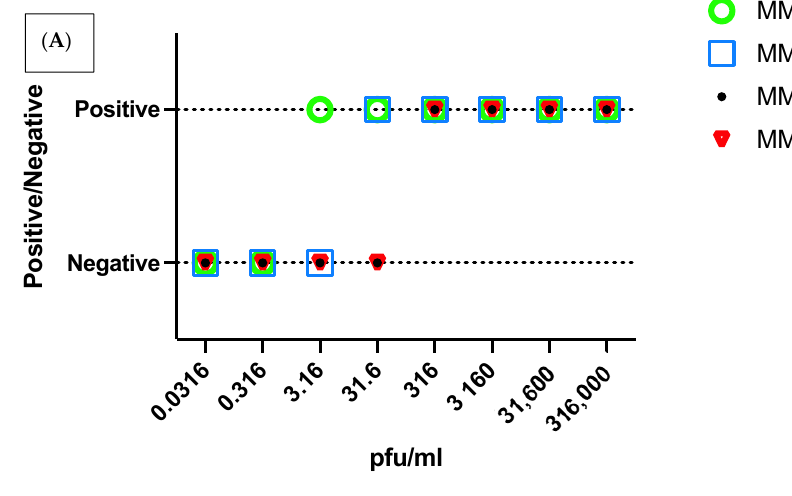
Figure 2. The LOD of MMix-A ( A ) and MMix-B ( B ) was evaluated at 60- 45- 40-, 35- and 30-min using cell culture isolates. The shortest time to give the highest level of detection (3.16 pfu/mL) for both assays was 45- and 30-min using MMix-A and MMix-B, respectively. 3.4. Evaluation of the Type of Mastermix Two RT-Lamp amplification reagents from New England Biolabs were used (MMix- A and MMix-B). MMix-A is commercially available (cat# E1700L), while MMix-B is an experimental lyo-compatible reagent. The LOD of both reagents was evaluated at 60-, 45- , 40-, 35-, and 30-min using cell culture isolates (Figure 2). The shortest time giving the highest LOD for both assays was 45 min; where MMix-A showed LOD of 3.16 pfu/mL and MMix-B showed a LOD of 3.16 × 10 − 1 pfu/mL whereas MMix-B showed a LOD of 3.16 pfu/mL at 30 min reaction time. As the LOD of diagnostic rtRT-PCR was found to be 3.16 pfu/mL, we used a reaction time of 45 min for MMix-A and 30 min for MMix-B to match the LOD of the standard assay in the clinical evaluation of the assays as shown in Figure